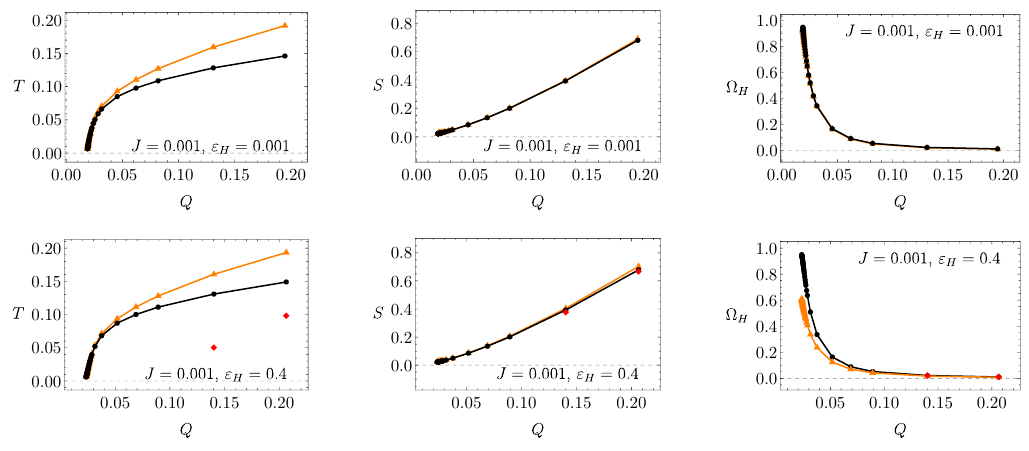
Figure 20 . First line : the comparison with the approximation of [13] for the same charge, mass, and angular momentum J = 0 : 001. Black disks are numerical results, and orange triangles are the predicted curves. We expect the model to be valid for small Q , small J , and near extremality. For small horizon scalar " H , the hairy black holes are just above the extremality and coexist with CLP solutions. As T ! 0, they approach the Gutowski-Reall solution. For small charge the participating soliton contributes Q s =Q ’ 0 : 5% of the total charge. Here the lowest T = 0 : 00633, and S = 0 : 0228. The error of the approximation to S close to the BPS bound is less than 1%. Second line : the constant " H = 0 : 4 curve crosses the extremality line. The red rhombi are the corresponding CLPs where they coexist in micro-canonical ensemble. For small charge, Q s =Q ’ 20%. Here